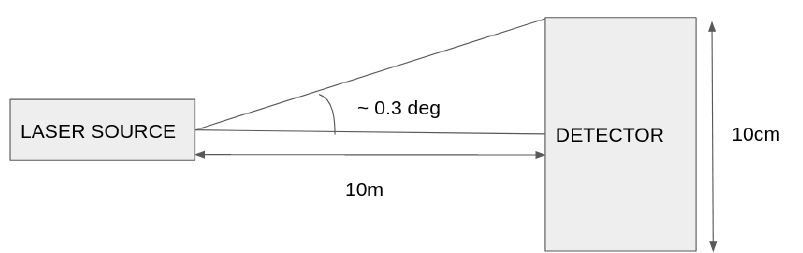
Figure 1. Optical measurement concept and the related marker tracking pointing requirement for distributed sensor system.